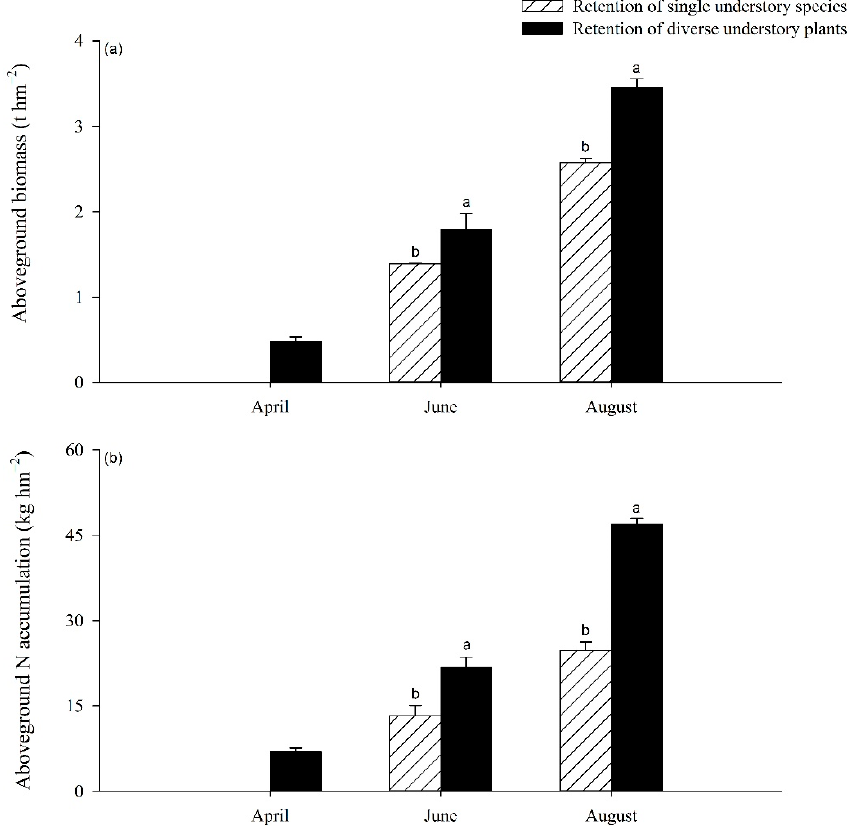
Figure 4. Aboveground biomass ( a ) and N accumulation ( b ) in the understory vegetation under RS and RD treatments. Different letters indicate significant differences between treatments at p < 0.05.